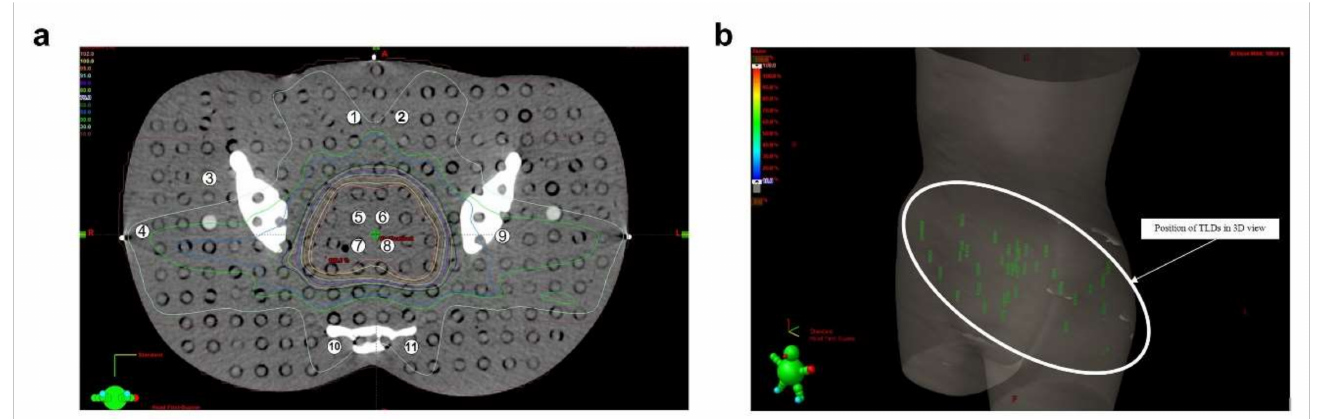
Figure 12. Ge-doped optical fiber for in-vitro. ( a ) Ge-doped optical fibers and LiF TLDs (highlighted) in 3D view. ( b ) Numbers correspond to the positions of Ge-doped optical fibers and LiF TLDs in a Rando-phantom CT slice. Reprinted with permissions from ref. [132]. Copyright 2010, Elsevier